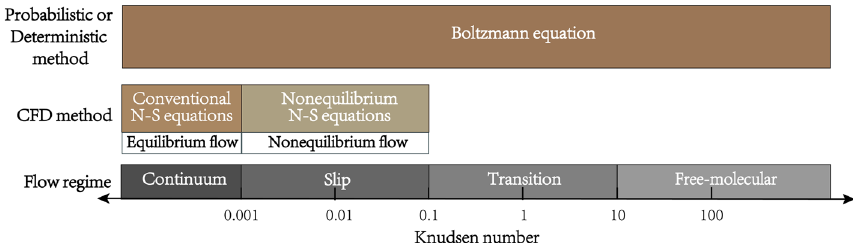
Fig. 3 Validity range of different flow